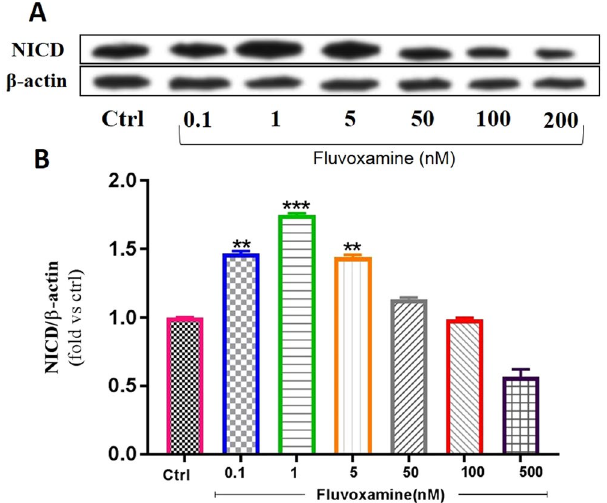
Figure 3. Effect of fluvoxamine on NICD protein expression levels. ( A ) Representative western blot showing NICD expressions. ( B ) Quantification of NICD expressions in all groups. β -actin was used as an internal control for normalization. Values are expressed as the Mean ± SEM. Each group included 5 replicates (n = 5). Statistical analyses were performed by one-way analysis of variance followed by Tukey’s test. Significance is indicated by * p < 0.05, ** p < 0.01, *** p < 0.001 and **** p <